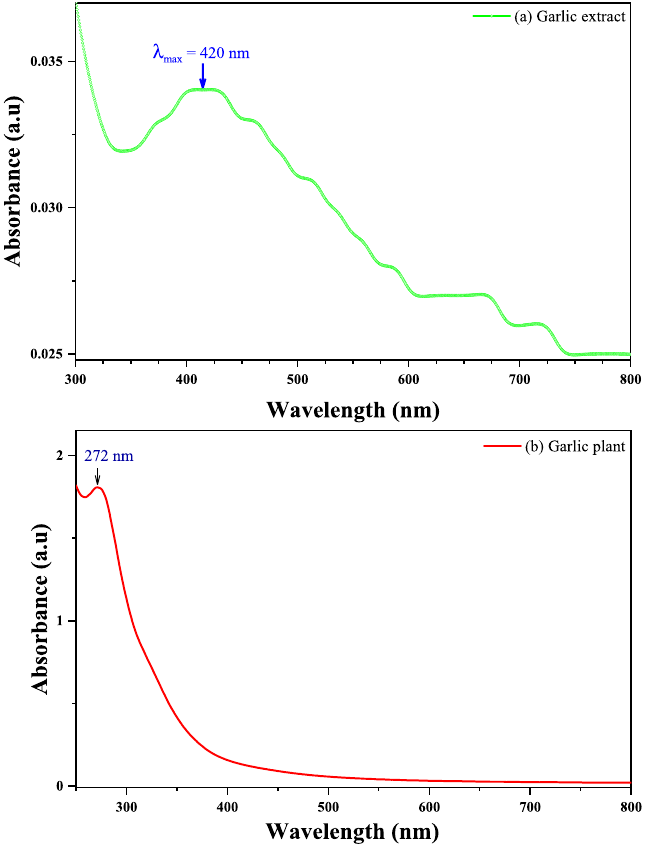
Figure 6. UV–visible absorbance spectra of AgO/AgNPs ( a ) extract garlic and ( b ) garlic plant.